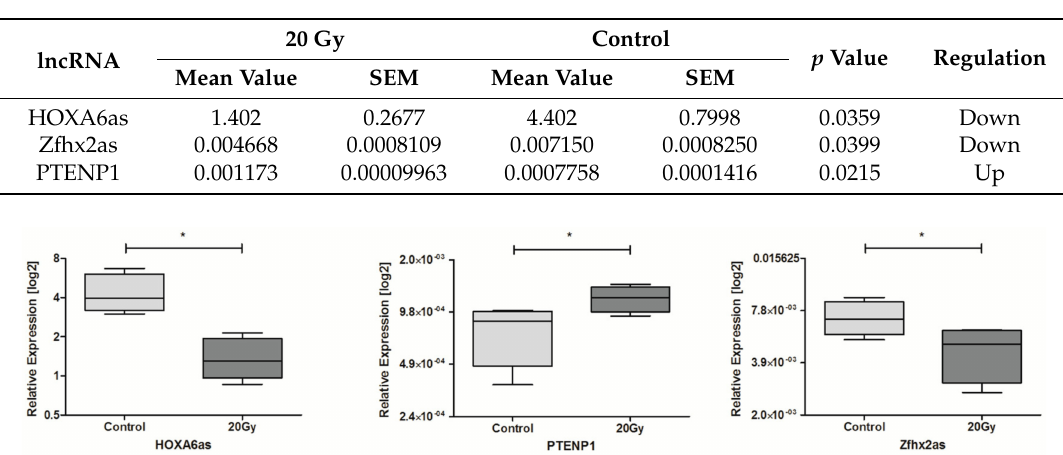
Table 4. Expression values of HOXA6as, PTENP1, and Zfhx2as after exposure to 20 Gy irradiation.